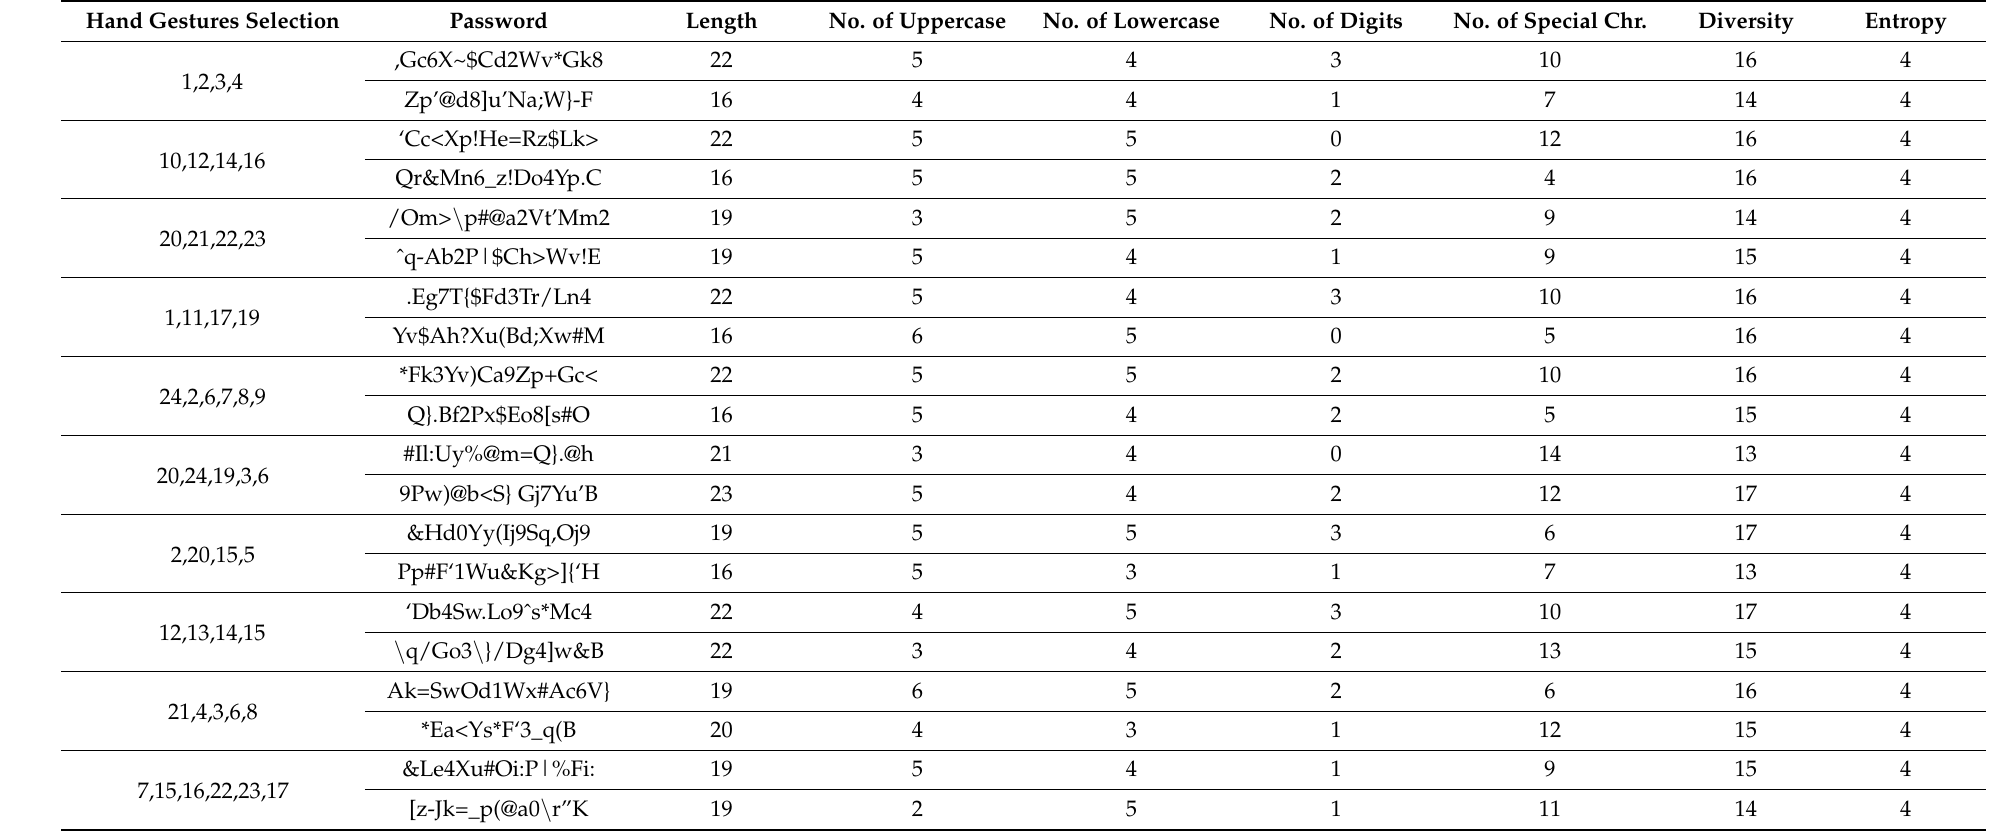
Table 7. The features of the generated